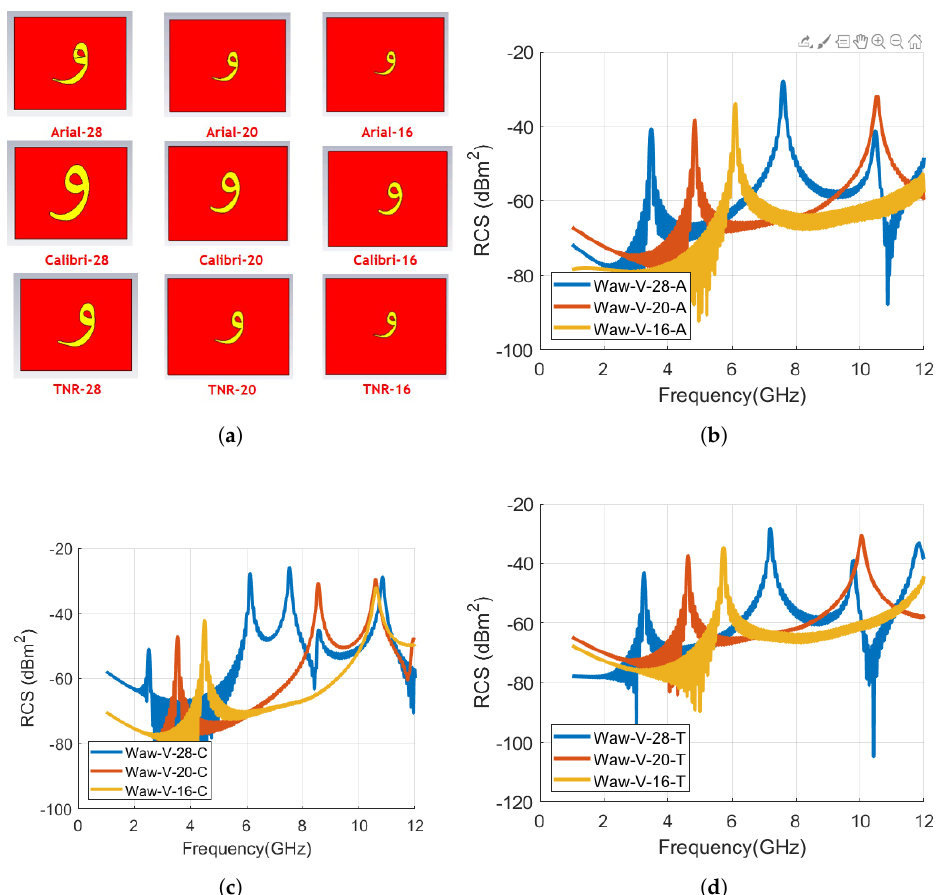
Figure 20. Designed letters and comparison of RCS results of alphabet (cid:240) tag for vertical polarization with various font types and sizes: ( d ) Design letter (cid:240) tag with different fonts and sizes; ( b ) Arial font with 28, 20, and 16 sizes; ( c ) Calibri font with 28, 20, and 16 sizes; and ( d ) Times New Roman (TNR) font with 28, 20, and 16 sizes.